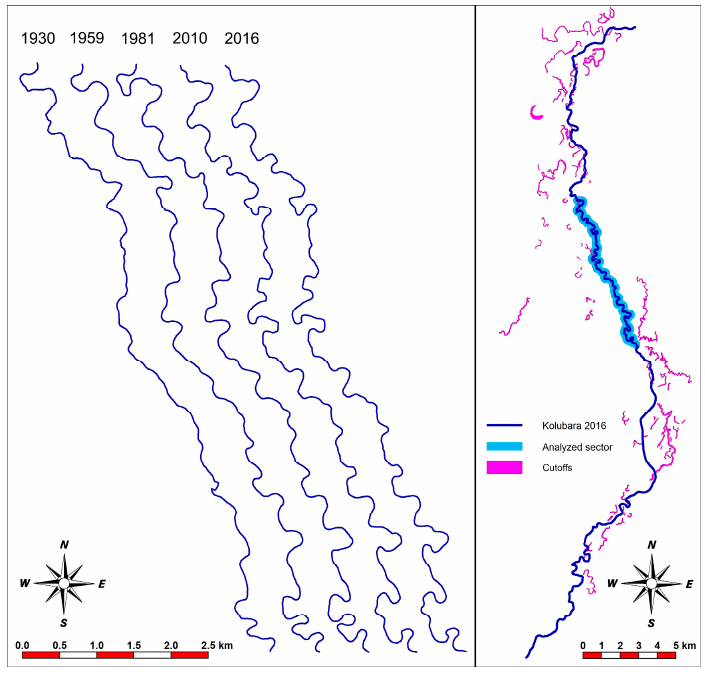
Figure 2. Successive channel planform changes for period 1930–2016 along the study area.